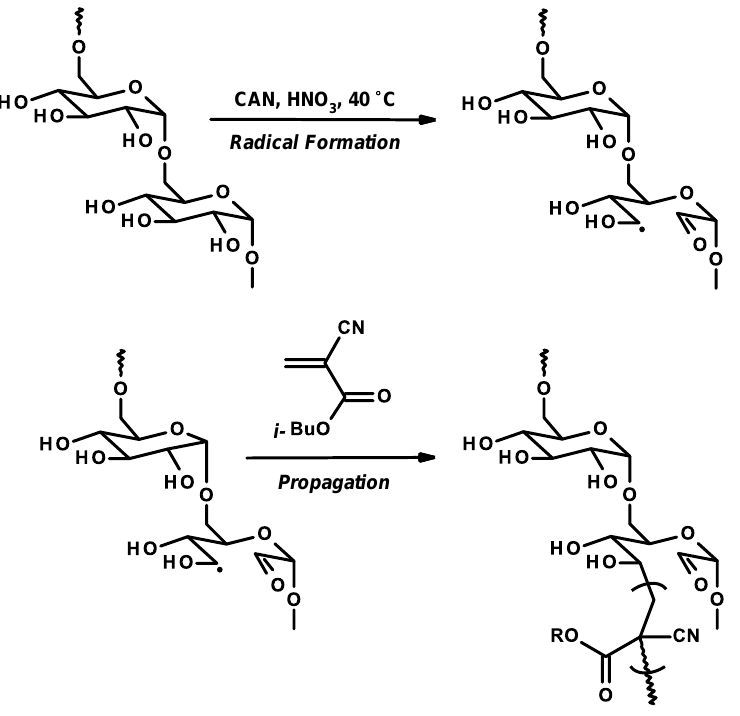
Scheme 14. CAN-initiated radical polymerization of